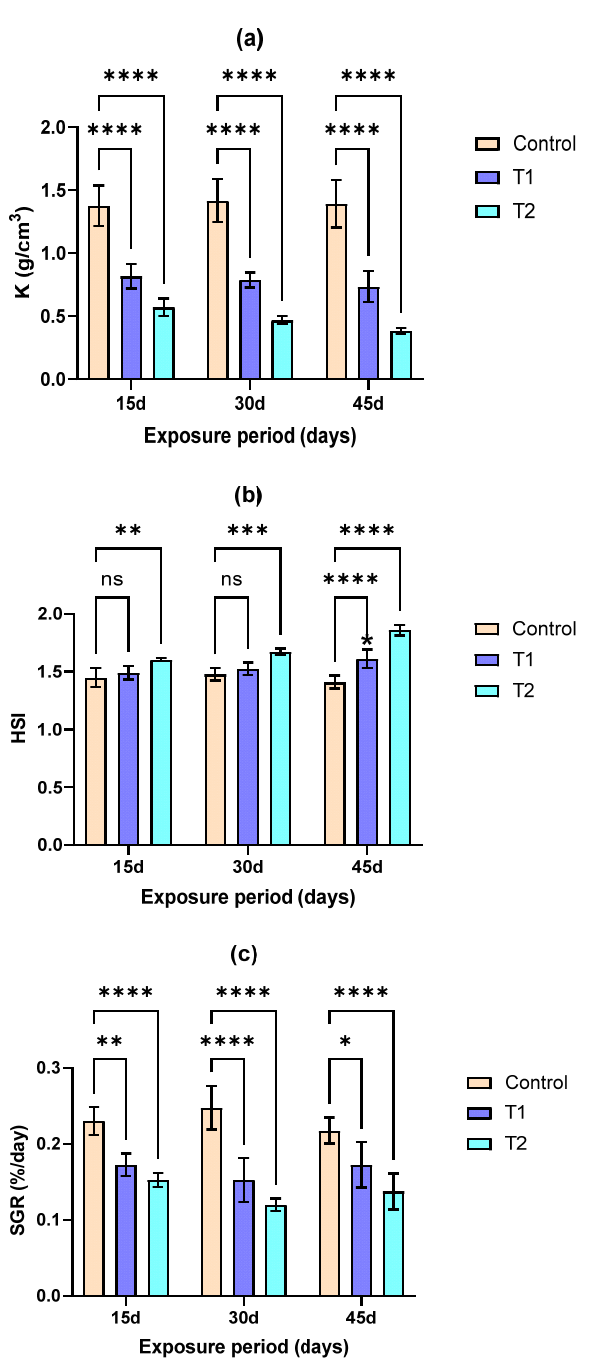
Figure 2. ( a – c ) Mean and SD values of growth endpoints and indices of Clarias batrachus exposed to different concentrations of diazinon (0.64 and 1.28 mg/L) for different exposure times (15, 30, and 45 days). *—denotes significant differences to control within the same exposure time (* p < 0.05, ** p < 0.01, *** p < 0.001 and **** p < 0.0001). ( a ) Condition factor (K); ( b ) hepatosomatic index (HSI); ( c ) specific growth rate (SGR).